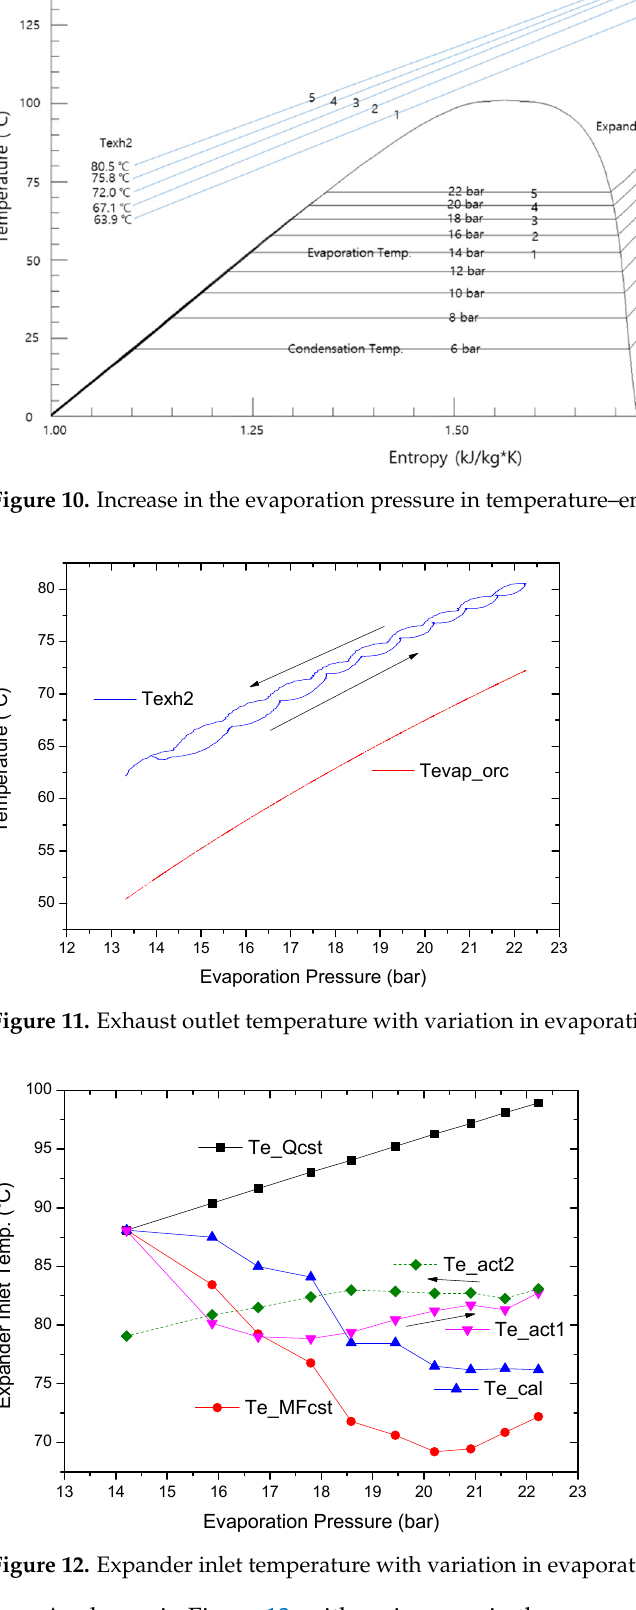
Figure 9. Expander inlet pressure and temperature over selected time interval.